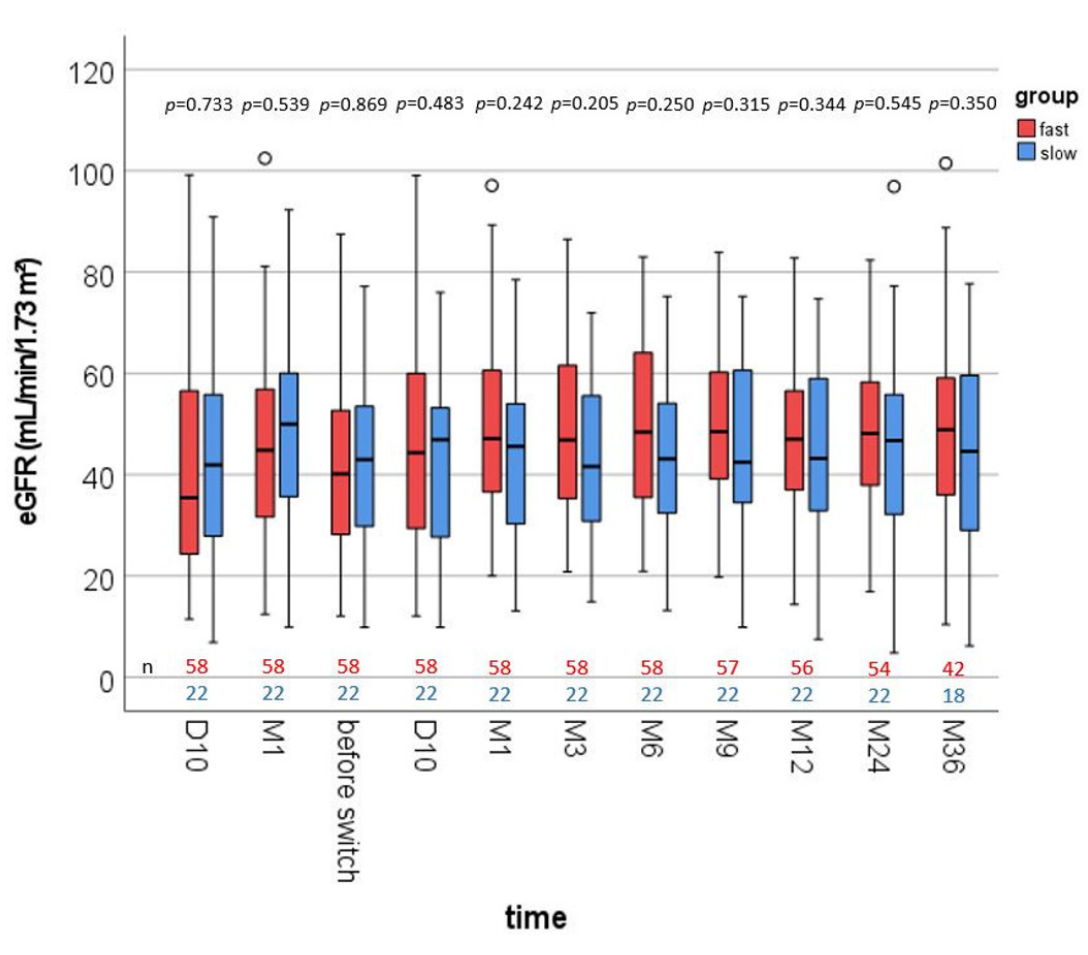
Figure 2. Boxplots of the renal function at different time points (eGFR, estimated glomerular filtration rate) within 3 years after kidney transplantation. p -values are from Mann–Whitney U tests comparing fast vs. slow metabolizers at each time point. There were no noticeable differences between the groups after conversion.